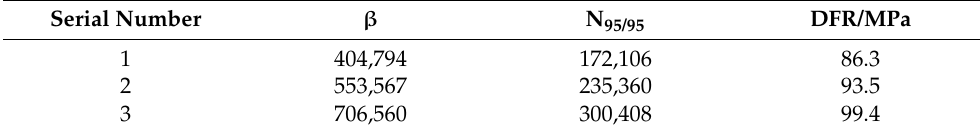
Table 6. Fatigue test data analysis